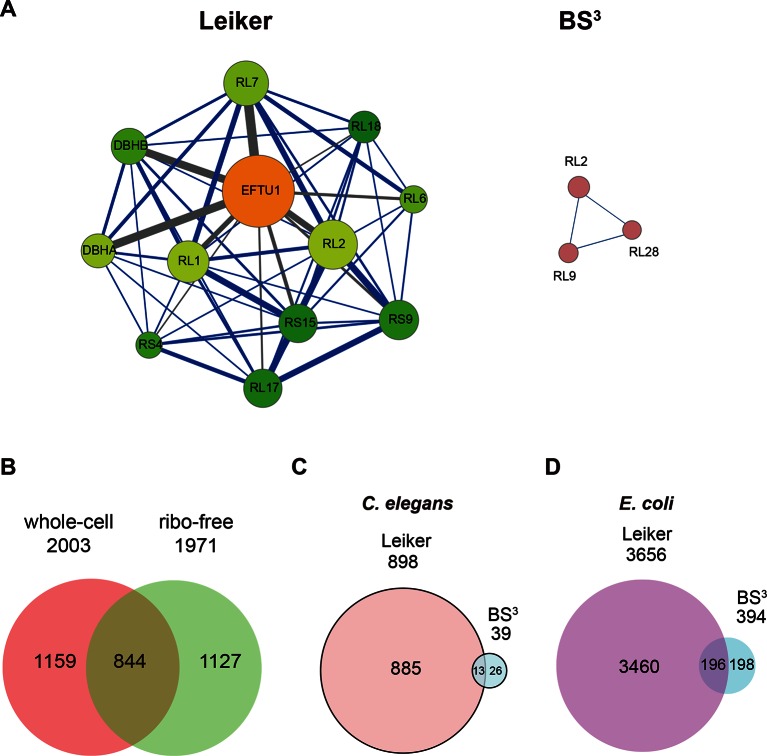
CXMS analyses of E. coli and C. elegans lysates.(A) The best protein-protein interaction cluster extracted from the Leiker-identified or BS3-identified (Yang et al., 2012) inter-links from E. coli whole-cell lysates. Node size represents the degree of connectivity of the indicated protein in the network. Line width represents the spectral counts of every inter-molecular cross-link. The line color is set to blue when the two peptides of an inter-link are both attributed to unique proteins, to grey if either could be assigned to multiple proteins. All the lines connected to EF-Tu1 are grey because EF-Tu1 differs from EF-Tu2 by only one amino acid. (B) Comparison of the identified inter-links in E. coli whole-cell lysates and ribo-free lysates (5% FDR, E-value < 0.01, spectral count ≥ 3). (C and D) Comparison of the number of Leiker-identified inter-links and that of BS3-identified inter-links (Yang et al., 2012) from C. elegans (C) and E. coli (D) whole-cell lysates (5% FDR, E-value < 0.01, spectral count ≥ 1).DOI:
http://dx.doi.org/10.7554/eLife.12509.02610.7554/eLife.12509.027Figure 5—source data 1.CXMS analysis of E. coli whole-cell lysates.DOI:
http://dx.doi.org/10.7554/eLife.12509.02710.7554/eLife.12509.028Figure 5—source data 2.CXMS analysis of E. coli ribo-free lysates.DOI:
http://dx.doi.org/10.7554/eLife.12509.02810.7554/eLife.12509.029Figure 5—source data 3.CXMS analysis of C. elegans whole-cell lysates.DOI:
http://dx.doi.org/10.7554/eLife.12509.02910.7554/eLife.12509.030Figure 5—source data 4.CXMS analysis of C. elegans mitochondrial proteins.